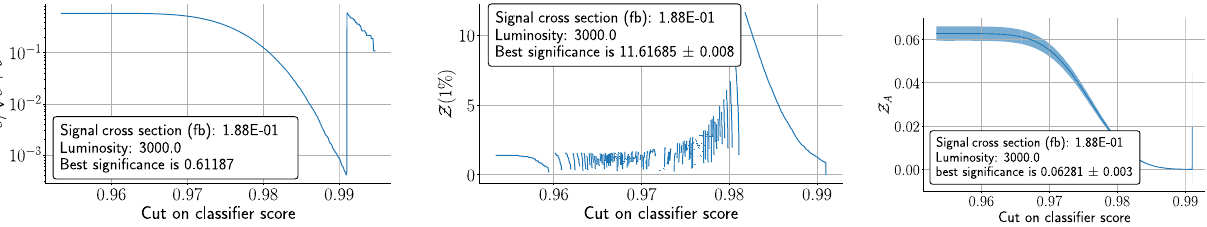
Fig. 7 Statistical significance as a function of the classifier score given by a neural network for different metrics, assuming a doublet-type VLL with M VLL = 700 GeV and a collider luminosity L = 3000 fb − 1 . The computation of the statistical significance is made using the best neural Fig. 8 Statistical significance as a function of the collider luminosity, for a fixed doublet VLL mass of 700 GeV (mixing in Eq. (14)). Target luminosities of the HL-LHC (3000 fb − 1 ) and Run III (300 fb − 1 ) are marked with vertical dashed black lines. Both axes are shown in logarithmic